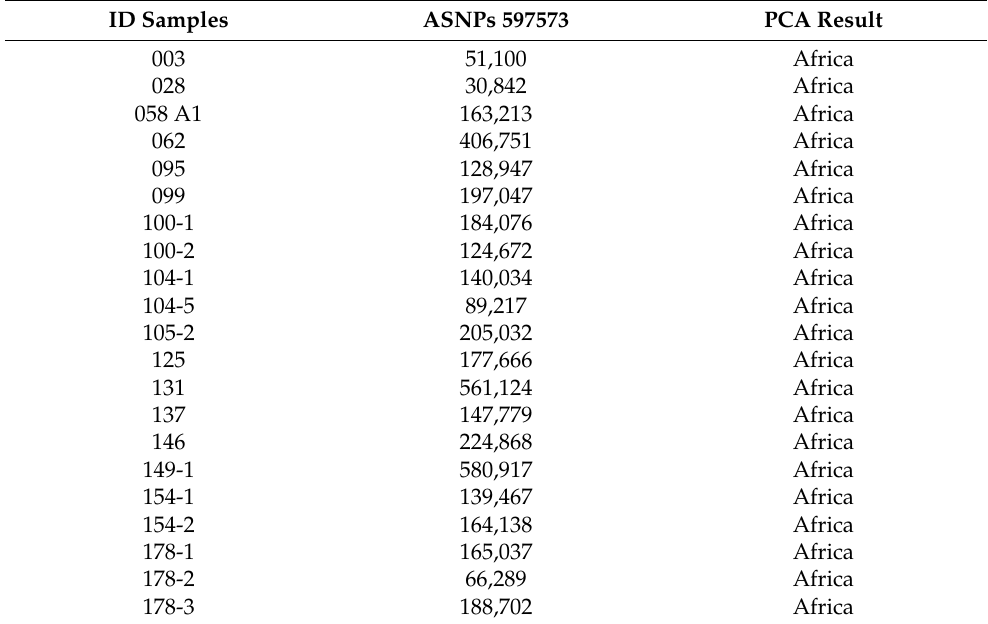
Table 2. A summary of ID samples, SNPs called for ancestry estimation of each individual, and the PCA